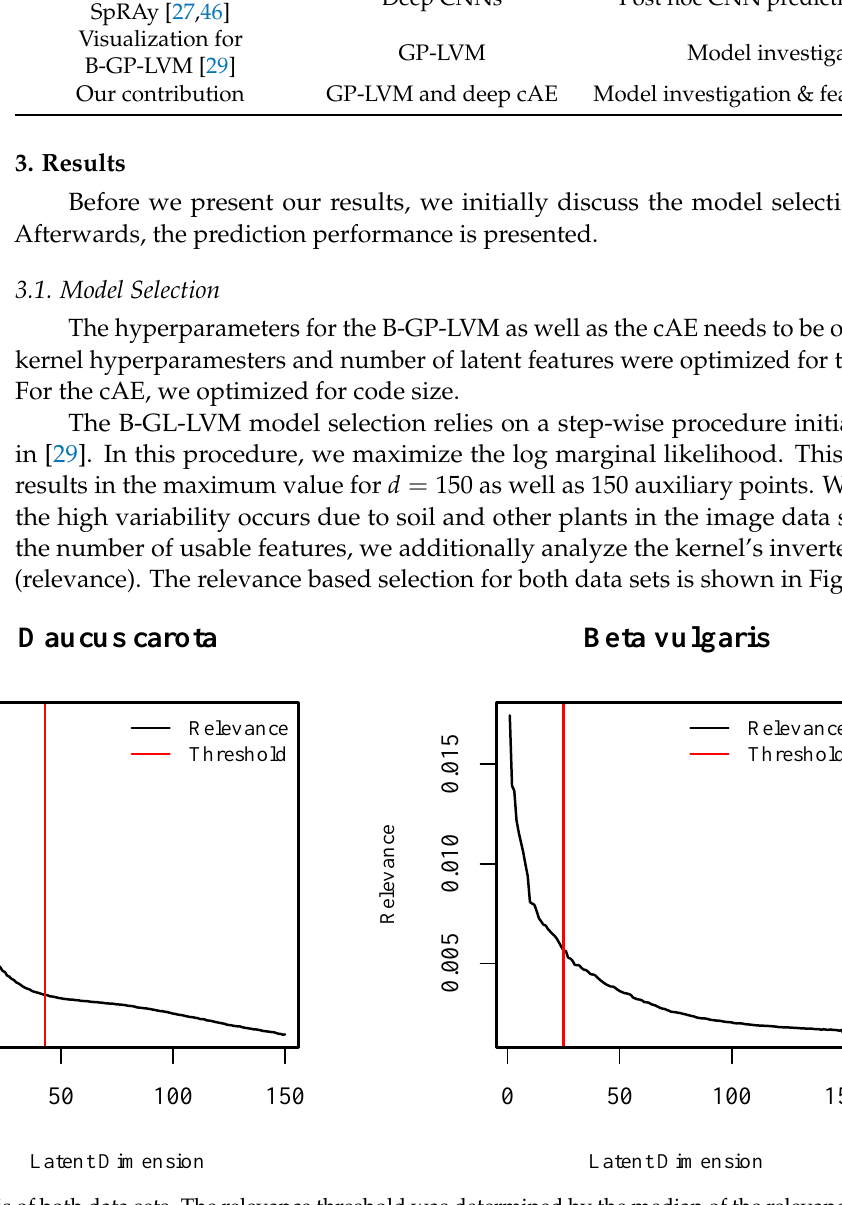
Figure 3. Relevance analysis of both data sets. The relevance threshold was determined by the median of the relevance